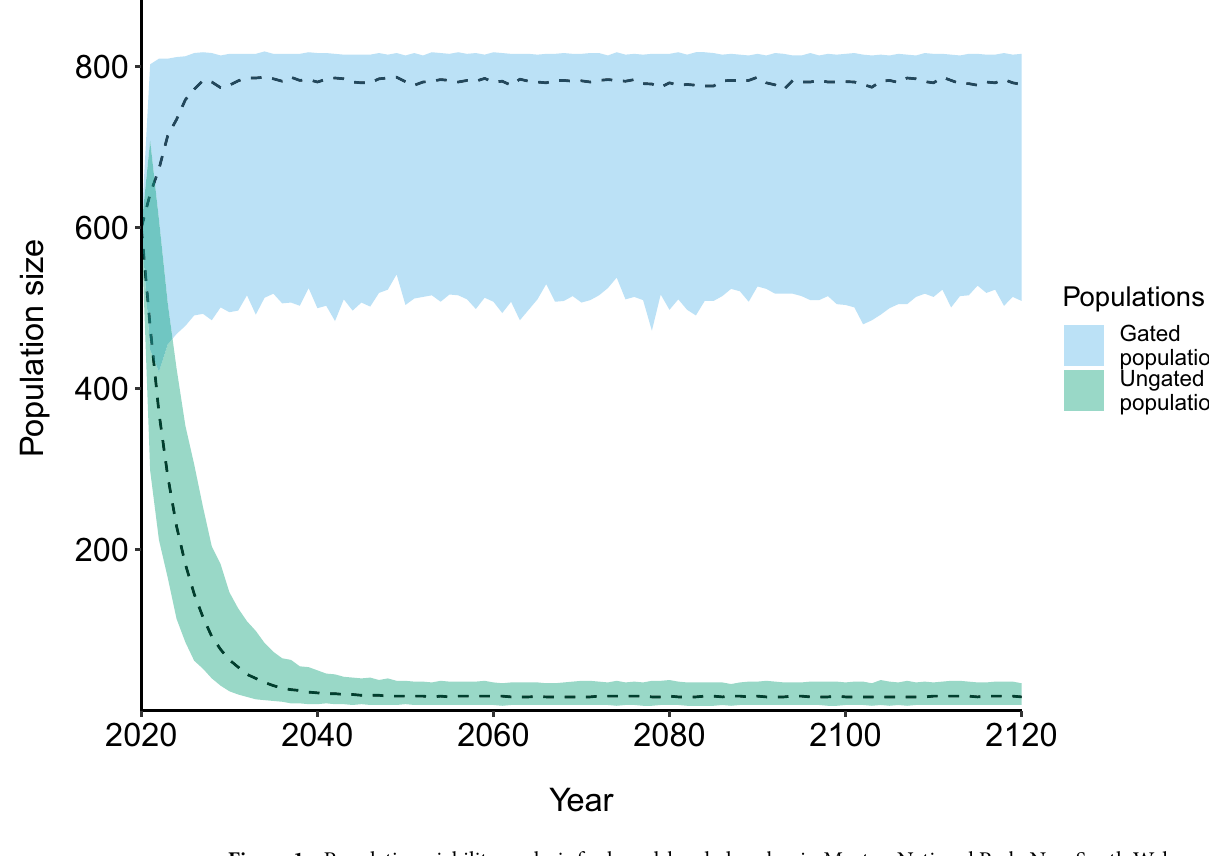
Figure 1. Population viability analysis for broad-headed snakes in Morton National Park, New South Wales, Australia. This figure represents the predicted population trajectories based on the life history parameters estimated from a long-term mark–recapture study of these populations. The ungated population (green) is only saved from local extinction by migration of juveniles from the gated population.